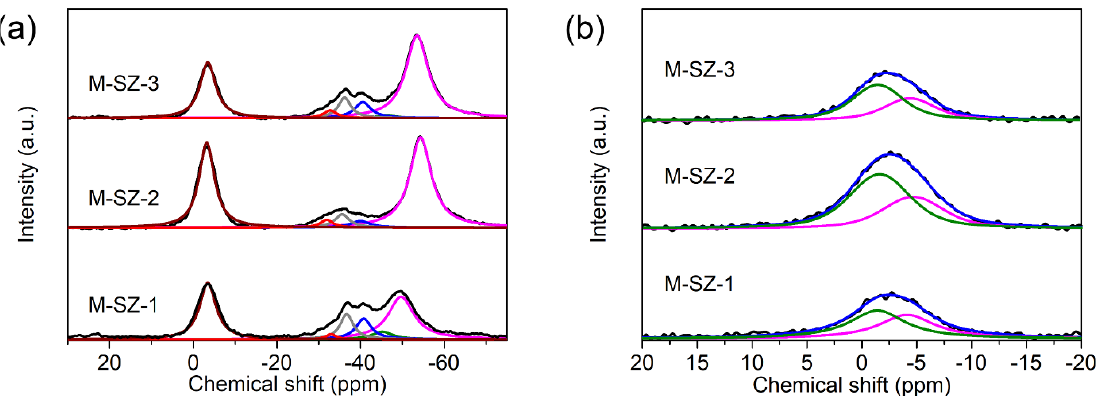
Figure 5. ( a ) 1 H-decoupled 31 P MAS NMR spectra and ( b ) single-pulse 31 P MAS NMR spectra of M-SZ-1, M-SZ-2, and M-SZ-3. Table 2. The acidity of M-SZ-1, M-SZ-2, and M-SZ-3 acquired from 31 P MAS NMR